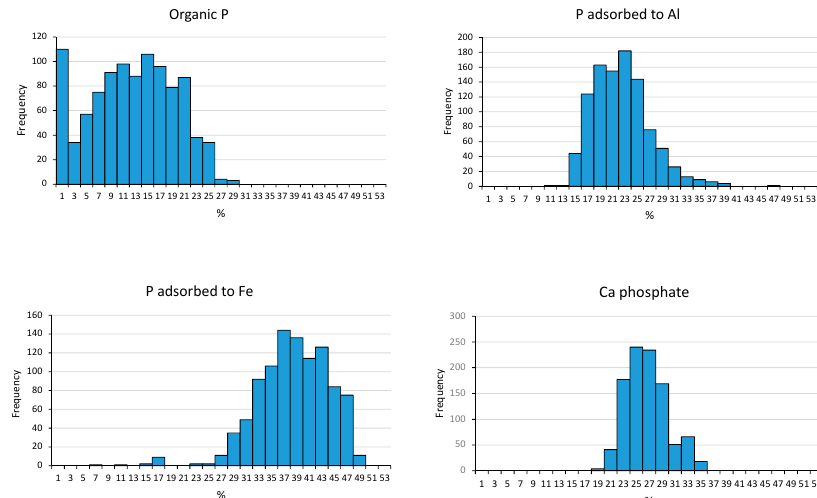
Figure 5. Histograms of the LCF-fitted percentages of different standard groups for the 203 FYM 0–28 sample (1000 data points).